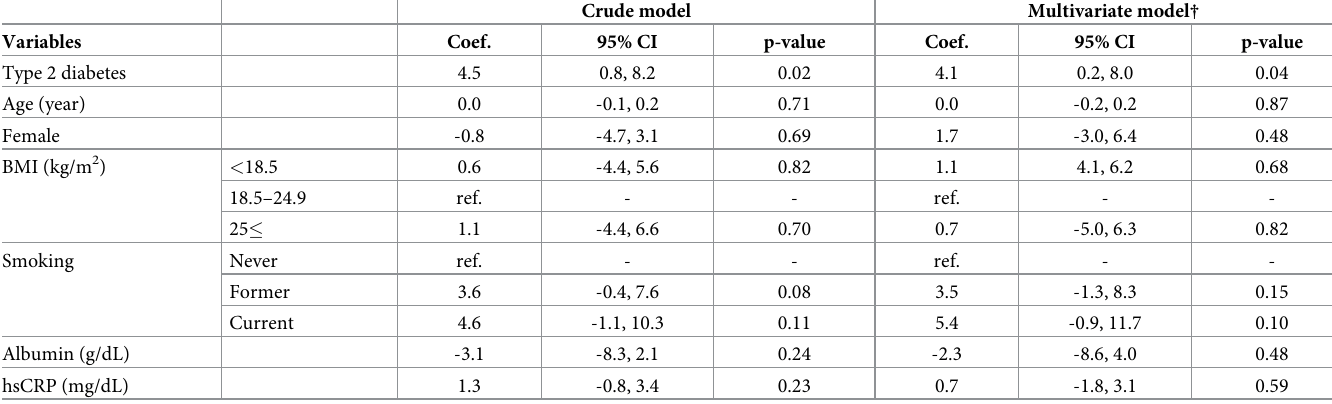
Table 3. Univariate and multivariate regression analysis of the factors influencing the proportion of sites (%) with PPD more than 4 mm in the study patients (n = 208).